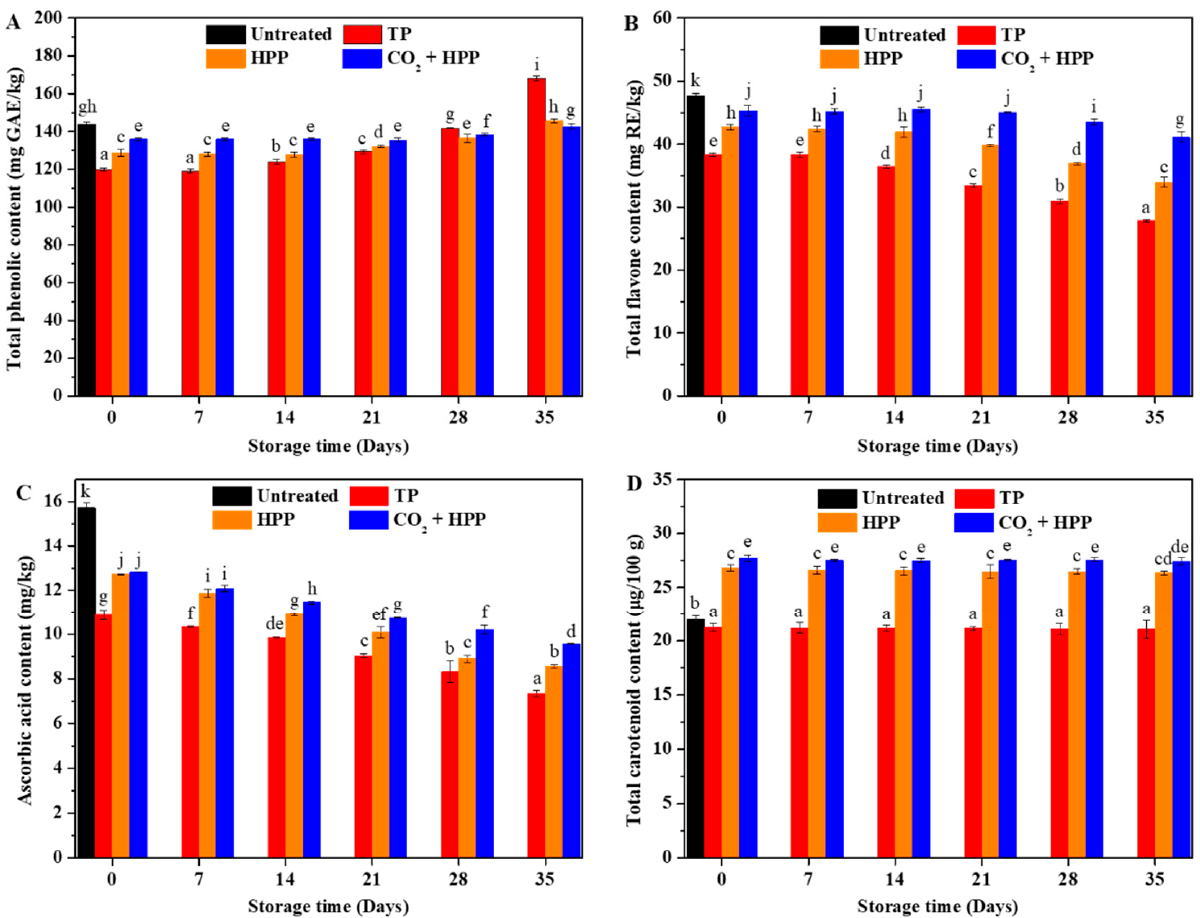
Figure 4. Analysis of total phenolic ( A ), total flavonoid ( B ), ascorbic acid ( C ), and total carotenoid ( D ) contents of TP—(95 °C, 60 min), HPP—(600 Mpa), and (CO 2 + HPP)—treated DFP (600 Mpa) during storage. Different letters (a, b, c, etc.) indicate significantly different means at p < 0.05 (analysis of variance (ANOVA)).